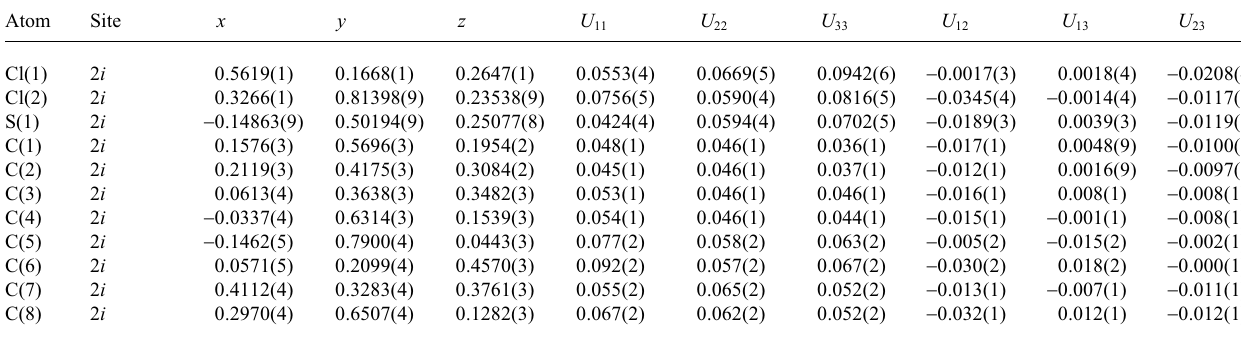
Table 3. Atomic coordinates and displacement parameters (in Å 2 )